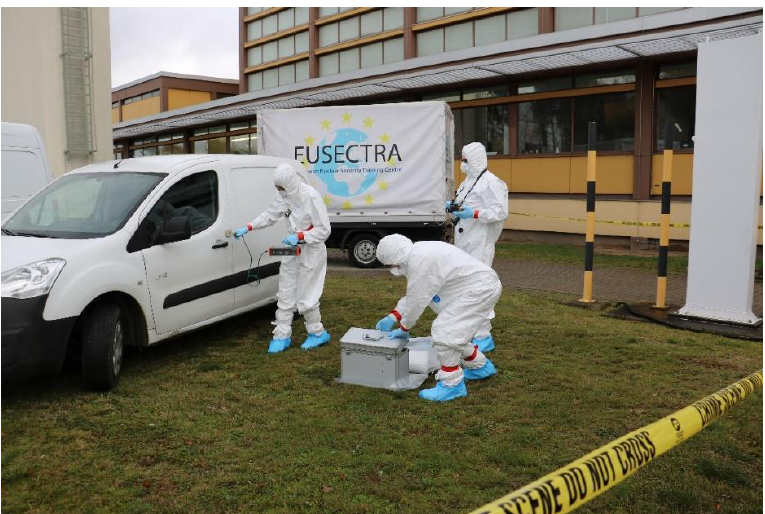
Figure 1: Outdoor facility of EUSECTRA with trucks & vans able to transport (and hide, for training purposes) real fissile materials. This picture was taken during a Radiological Crime Scene Management Training. © European Commission (2020, JRC